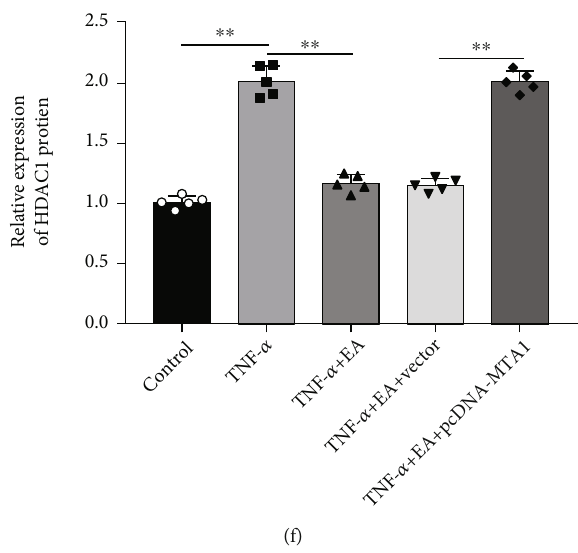
Figure 3: MTA1 interacted with HDAC1 and promoted HDAC1 expression. (a) The interaction between MTA1 protein and HDAC1 protein was veri fi ed by Co-IP assay. (b – d) pcDNA-MTA1, si-MTA1, and their negative controls were transfected into MH7A cells, respectively. The expression of MTA1 and HDAC1 was measured by Western blot analysis. (e, f) TNF- α -treated MH7A cells were treated with 50 μ M EA alone or together with pcDNA-MTA1. The expression of HDAC1 was measured by Western blot analysis. Data from at least three replicate experiments were presented as mean ± SD . N = 5 . ∗∗ P < 0 : 01